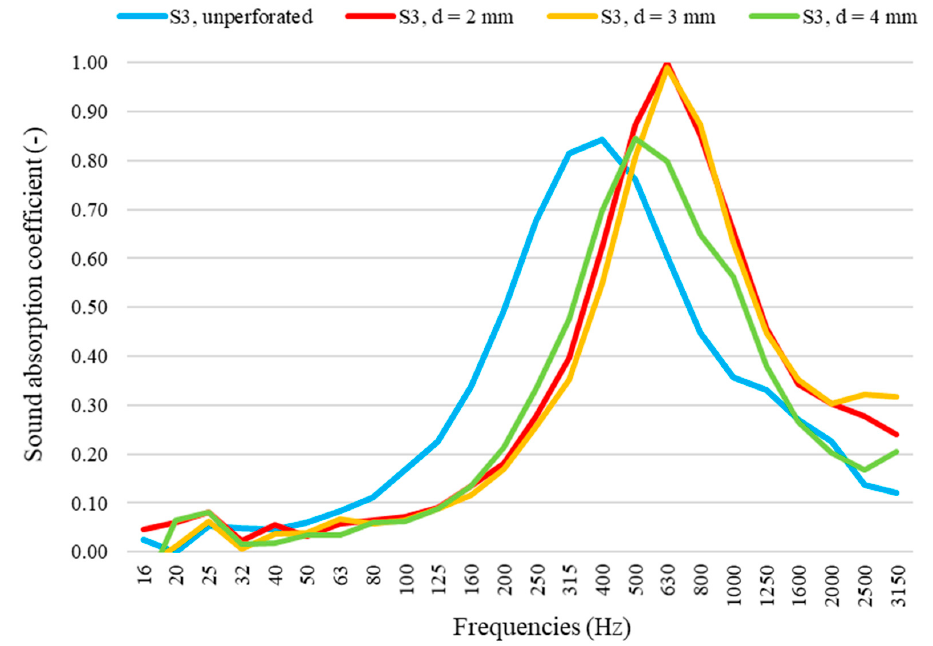
Figure 6. Sound absorption coefficient variation with different perforation diameters (sample S 3 ).